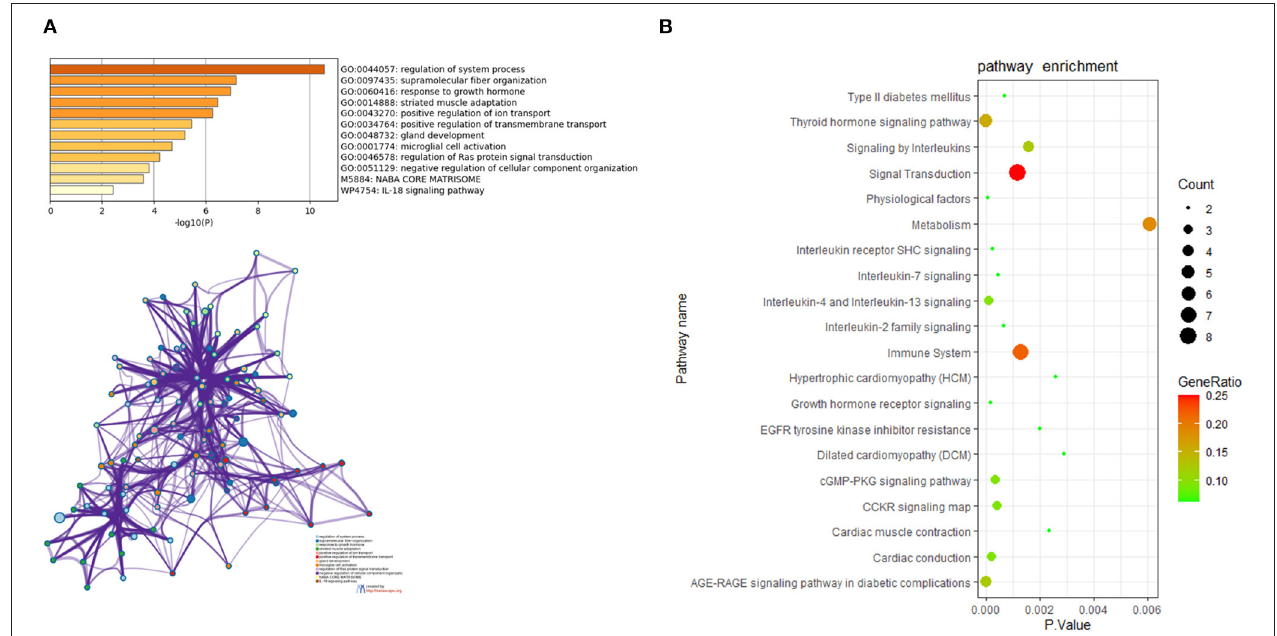
FIGURE 4 | (A) The functional annotation analysis of the communal DEGs by Metascape. (B) The pathway analysis of the communal DEGs by KOBAS version